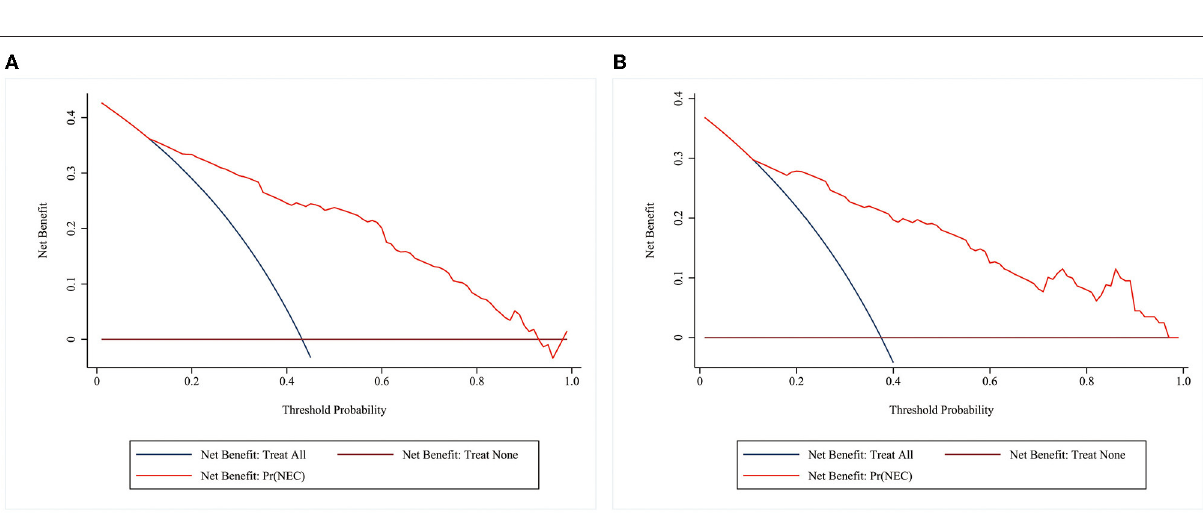
FIGURE 5 | DCA curves of the model in the training and validation groups . The horizontal coordinate is the threshold probability. The vertical coordinate is the net benefit after subtracting the harm (misdiagnosis) from the benefit (the benefit is for the patient to be treated). The brown reference line indicates that all patients don’t receive any intervention, and the net benefit is zero. The dark blue reference line indicates that all patients receive treatment, and the net benefit is represented by the backslash of the slope. The further the model curve is away from the two reference lines, the better the clinical utility of the nomogram. (A) DCA of the model in the training group (B) DCA of the model in the validation